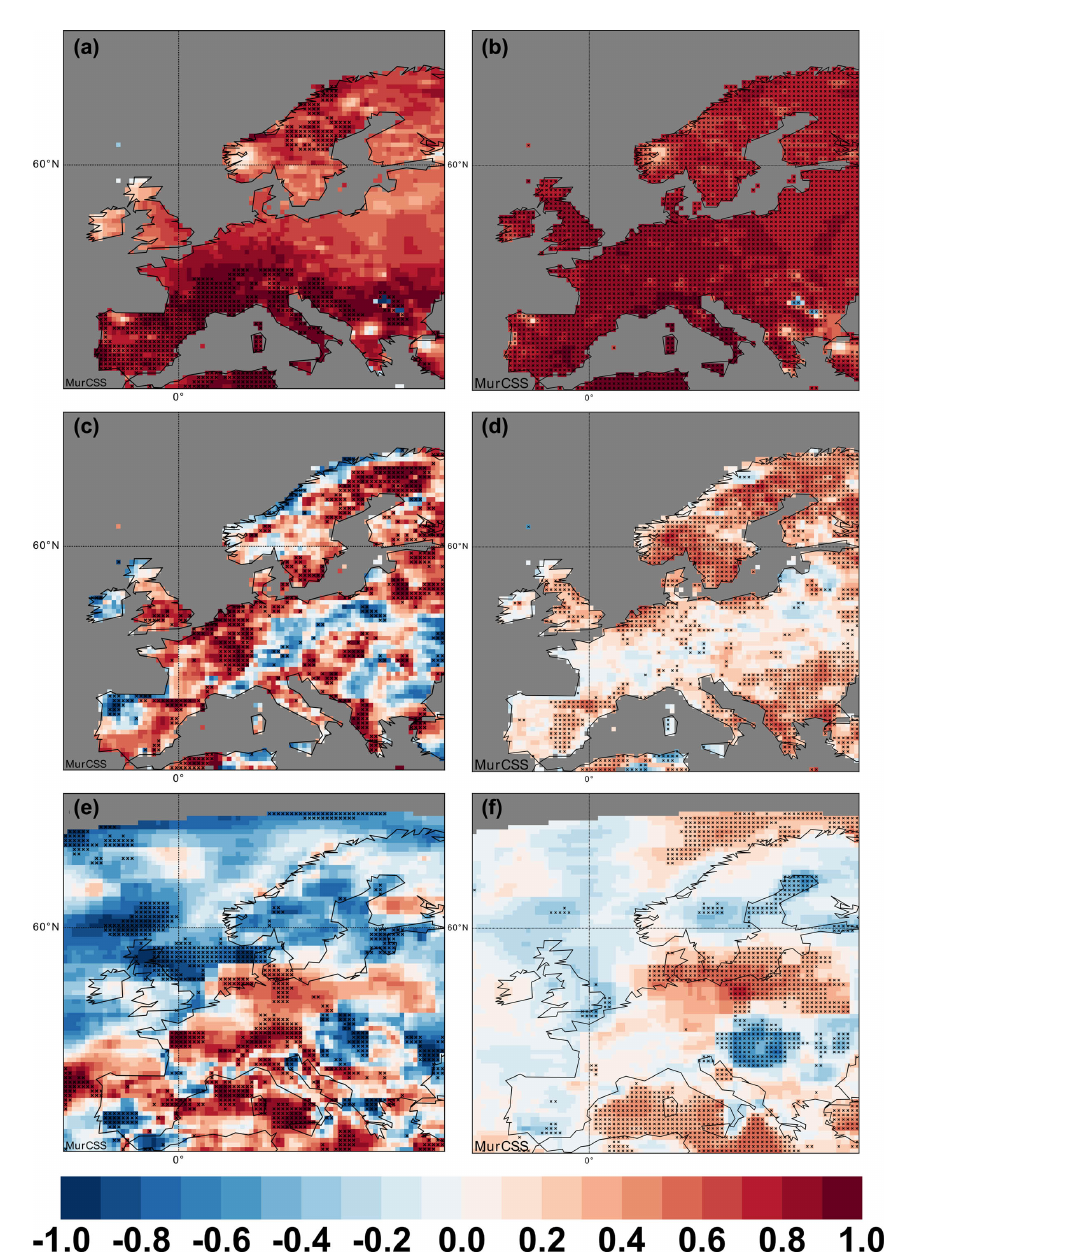
Figure 6. Spatial distribution of the ACC for the multi-annual mean anomalies of lead years 1–5 in MPI_b1 for (a, b) temperature, (c, d) pre- cipitation, and (e, f) wind speed. For (a, c, e) five start years (dec1960, dec1970, dec1980, dec1990, dec2000) have been used, while for (b, d, f) all start years from dec1960 to dec2000 are taken into account. The black dots indicate significant skill at the 95% level (bootstrapping). For more details see the main